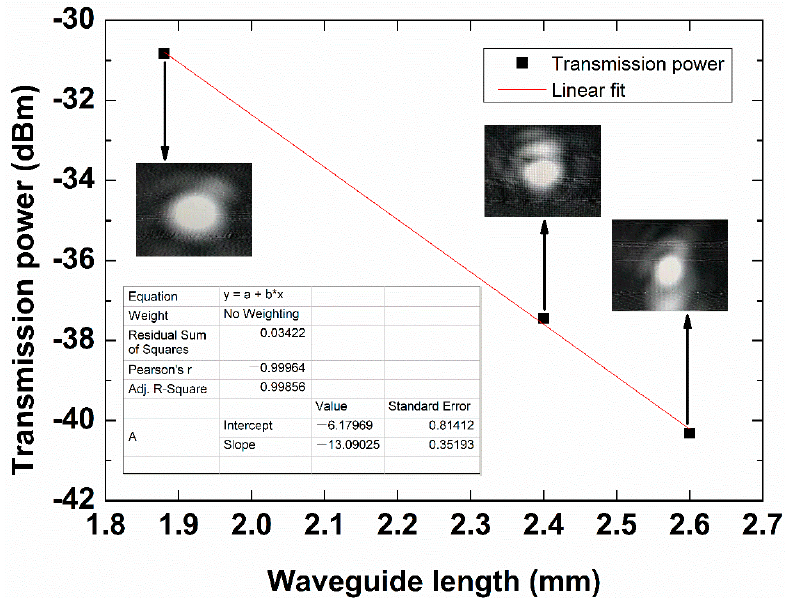
Figure 13. Transmission power as a function of LRSPP waveguide length at optical wavelength 850 nm. Linear fitting of the measured insertion loss of LRSPP waveguides with different lengths yields a mode power attenuation MPA w of 13.09 dB/mm at an adjusted R-squared of 0.99856 and a standard deviation of 0.814. Insets show the far field LRSPP mode patterns.